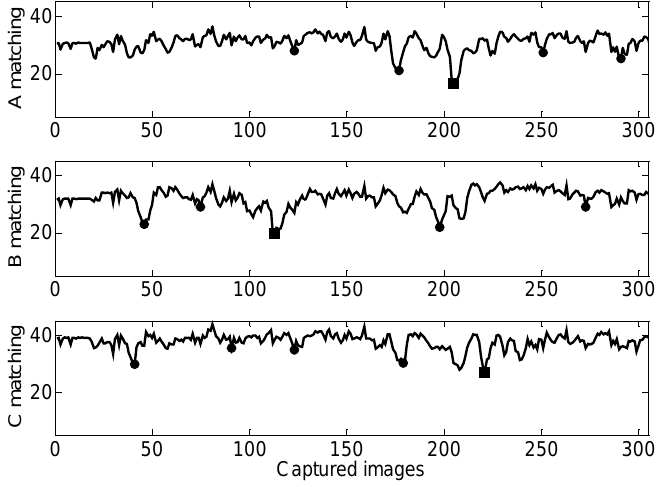
Figure 15. Evolution of the matching results in one rotation of three template images for an invalid two-Euro coin. The solid squares depict the angular position of the best